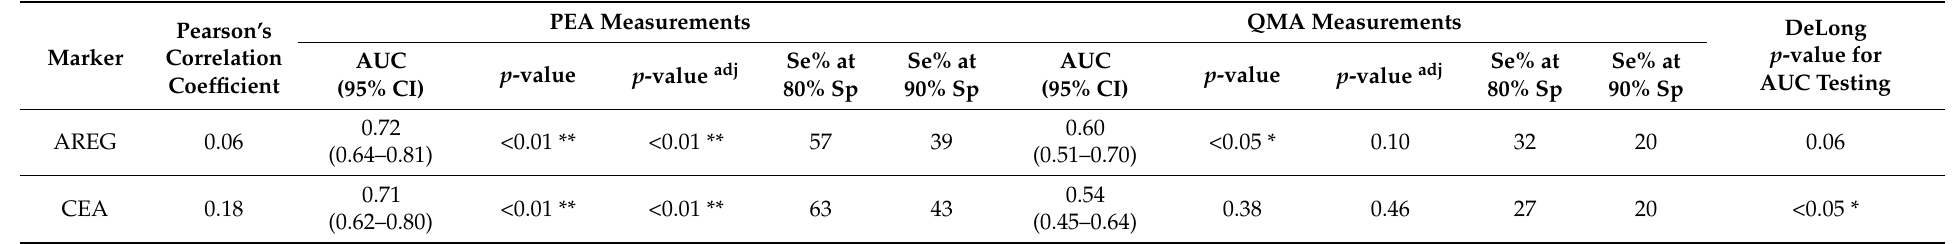
Table 3. Diagnostic performance of six biomarkers overlapping between PEA and QMA measurements for detecting CRC cases from participants in screening colonoscopy. Pearson’s Correlation Marker